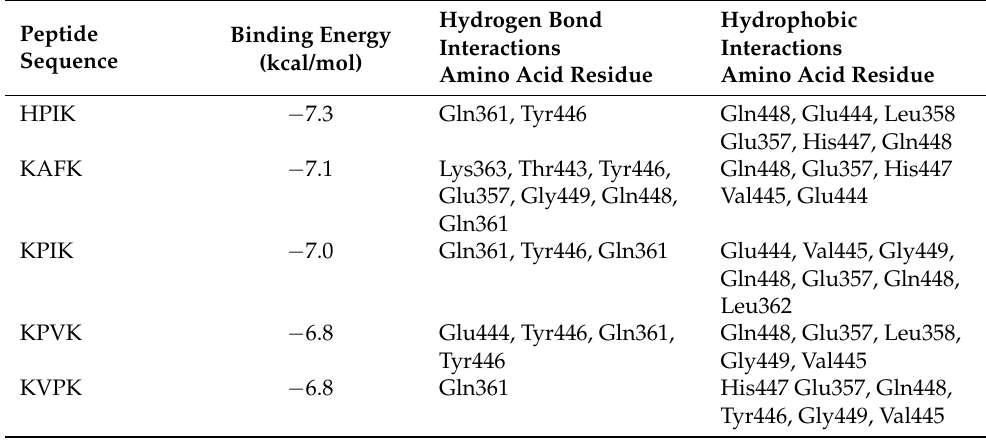
Table 6. Binding energy and interactions of potential active SCPs and standard molecule (stattic) on STAT3 (PDB ID: